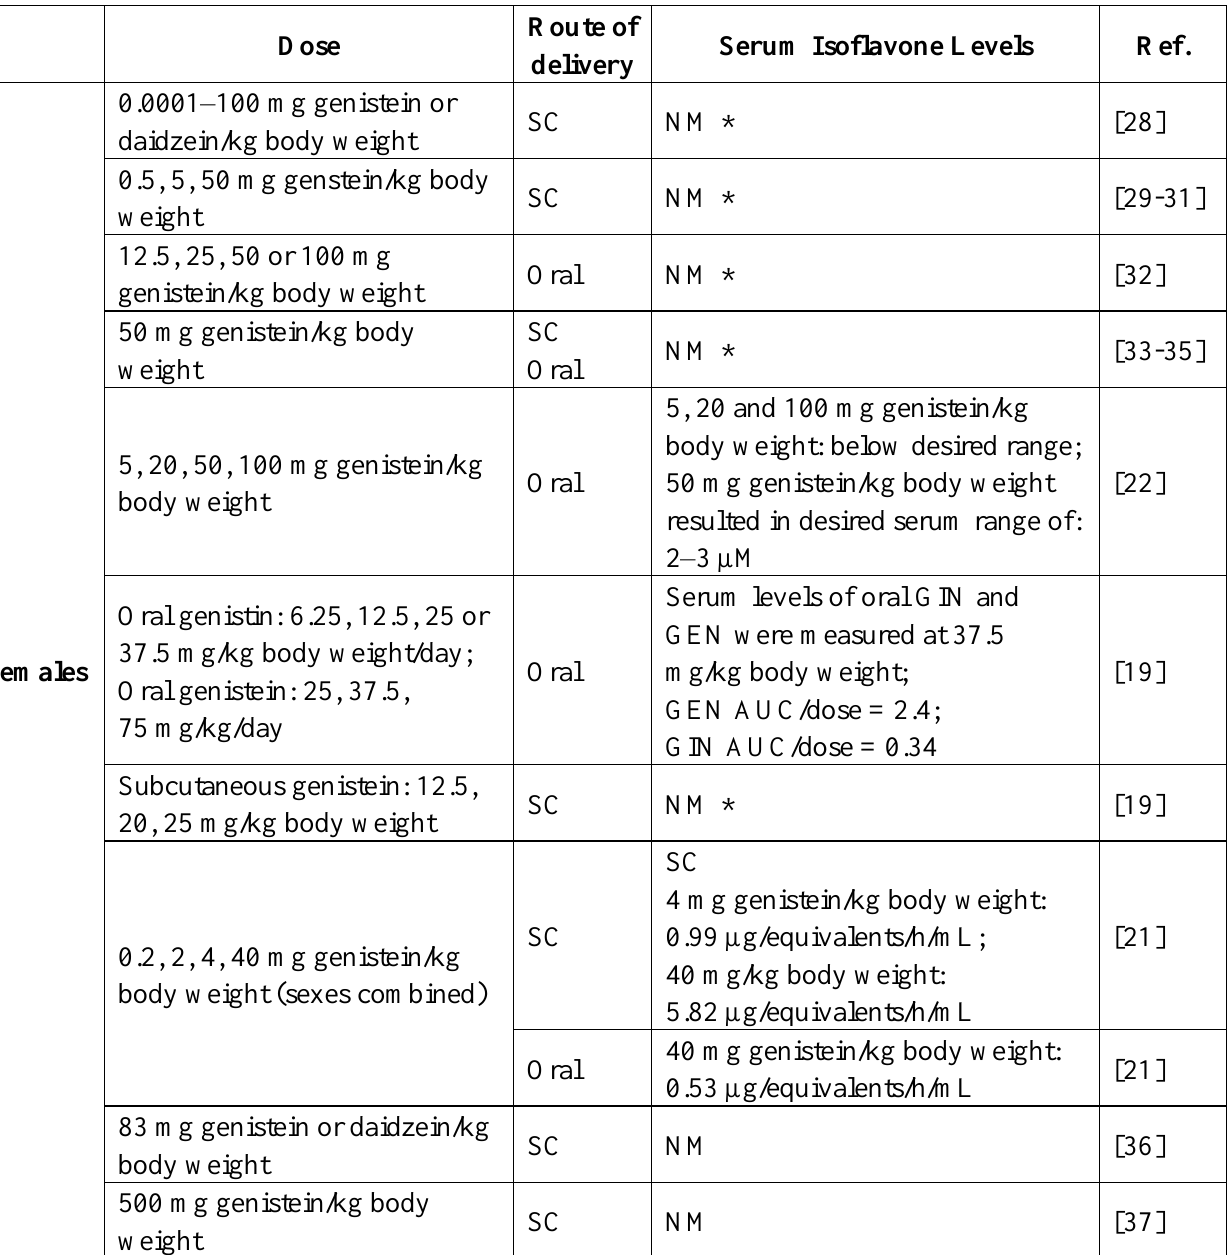
Table 3. Summary of isoflavone doses, route of administration and serum measurements in rodent models studying reproductive